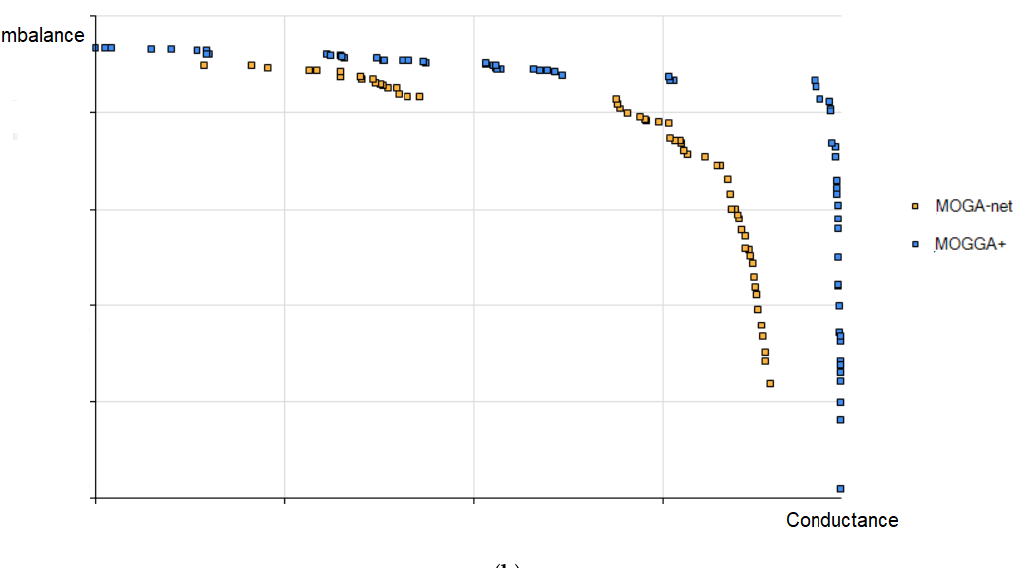
Figure 3. Comparison between MOGA-Net and MOGGA+ in the Italian network considering ( a ) modularity and imbalance, and ( b ) conductance and imbalance.